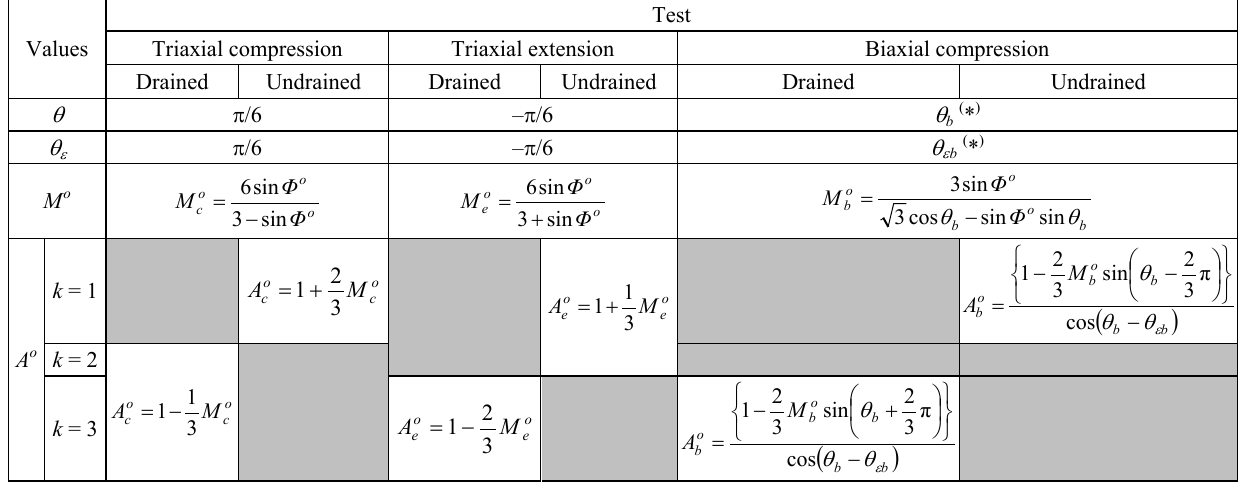
Table 1. Characteristic values of the stress-natural dilatancy